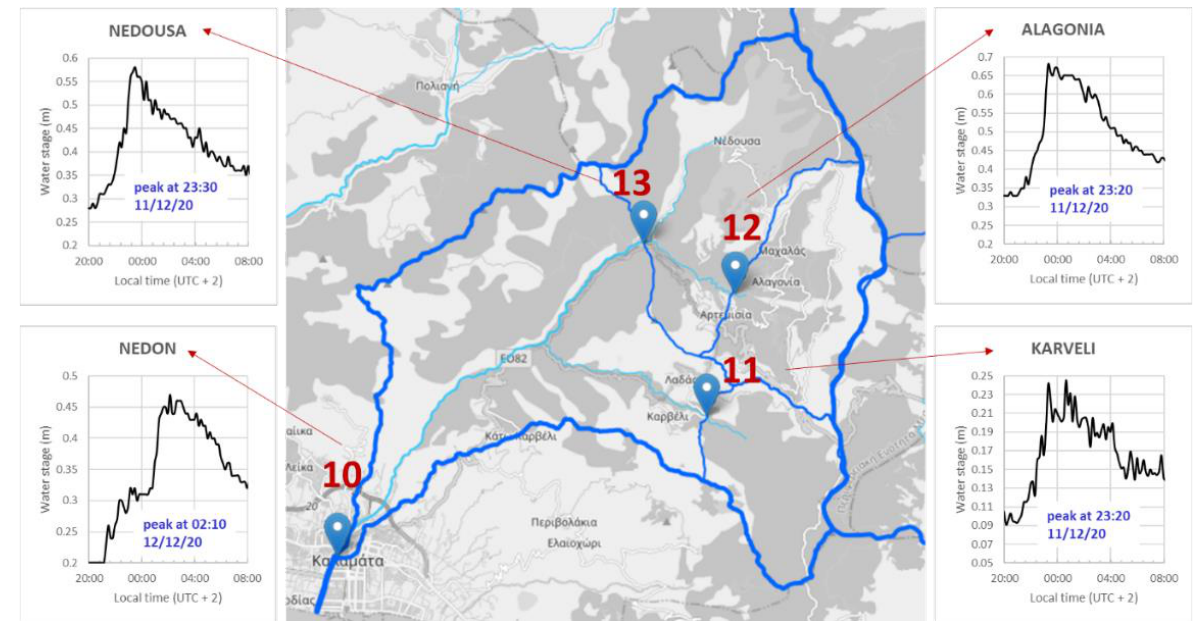
Figure 11. Demonstrator of a potential HYDRONET service: flood warning for Kalamata’s Centre.